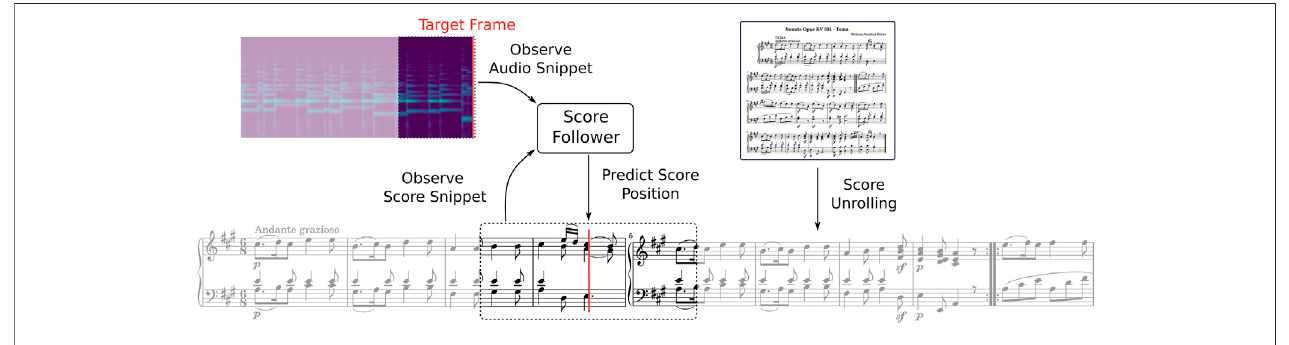
FIGURE 2 | Sheet-image based score following using unrolled score representations. First, the systems on a sheet image page must be detected, cut out and stitched together to along (unrolled) sequence. The score following system then observes asmall excerpt of thefullscore sequence aswell asthe audio (usually thelast 2 seconds). Based on this input, the score follower has to predict the most likely position in the sheet excerpt matching the target audio